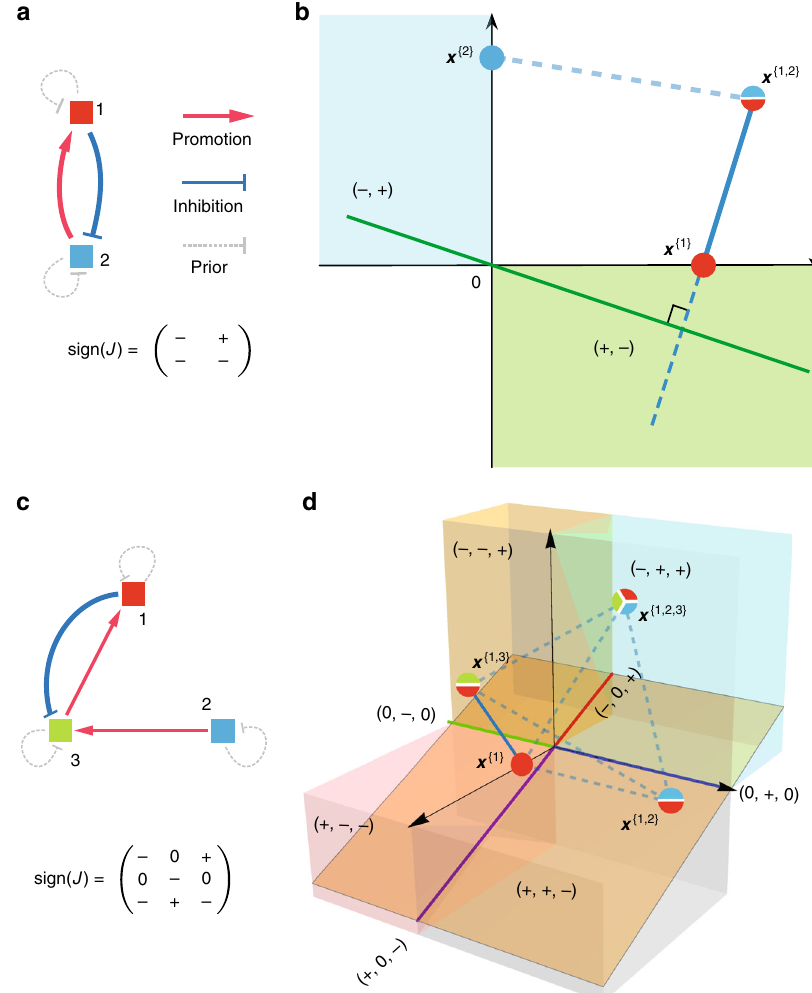
Fig. 1 Inferring ecological interaction types for a small microbial community. The interaction types are coded as the sign-pattern of the Jacobian matrix. a For a microbial community of two taxa, its ecological network and the sign-pattern of the corresponding Jacobian matrix are shown here. b There are three possible steady-state samples (shown as colored pie charts), and two of them x f 1 ; 2 g ; x 1 f g share taxon 1. We calculate the green line that passes through the origin and is perpendicular to the vector ð x 1 ; 2 f g (cid:4) x 1 f g Þ (shown as a blue line segment). This green line crosses the origin, and two other orthants (shown in light cyan and green), offering a set of possible sign-patterns: 0 ; 0 ð Þ ; ð(cid:4) ; (cid:4)Þ and ðþ ; (cid:4)Þ , for which s 1 ¼ ð sign J 11 ð Þ ; sign ð J 12 ÞÞ may belong to. Provided that J